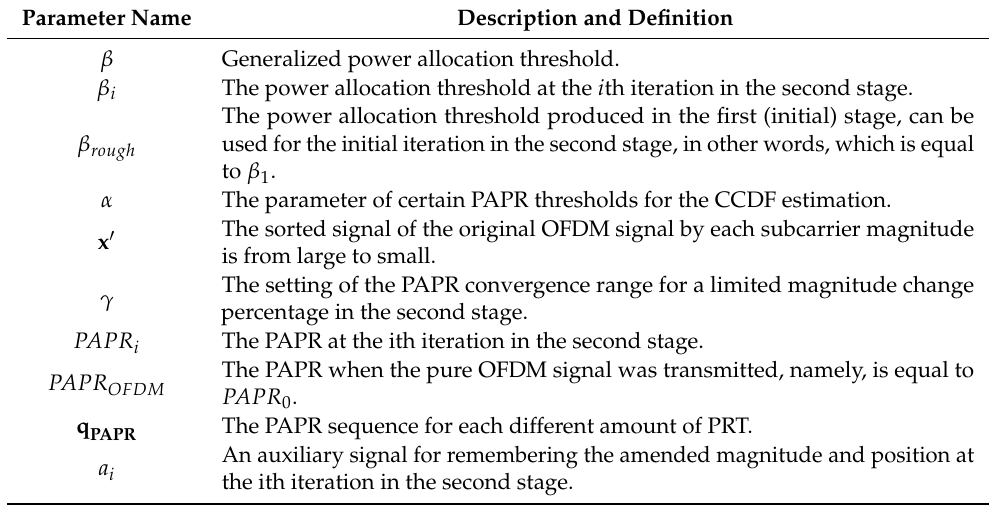
Table 1. The definitions of important notices and